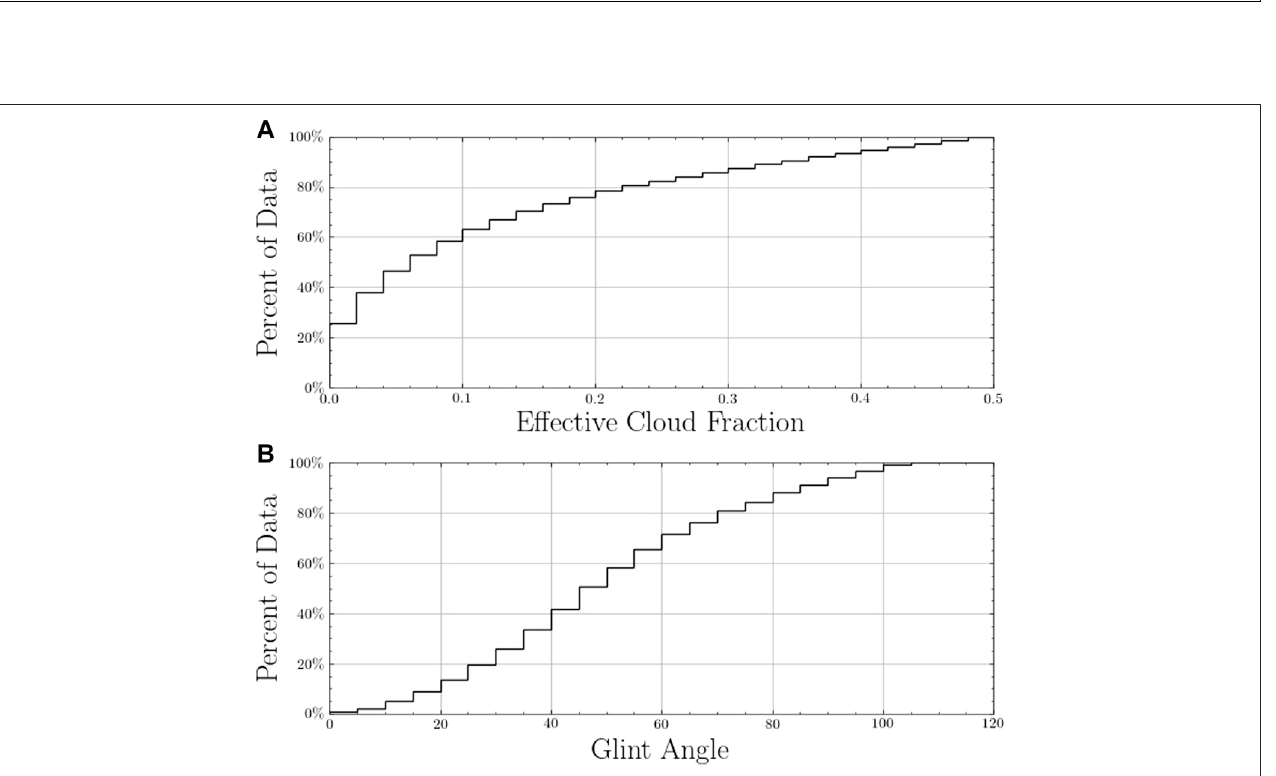
Frontiers in Remote Sensing |